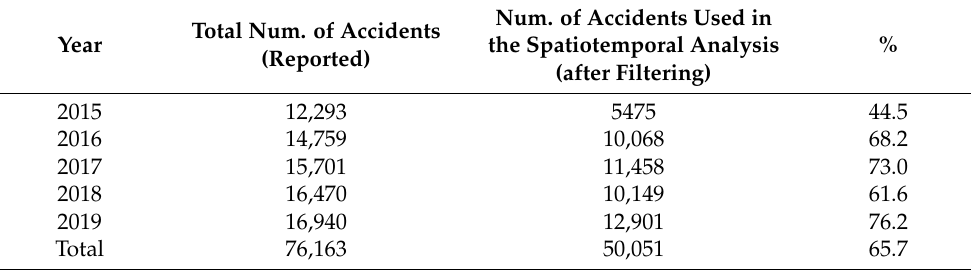
Figure 3. Examples of the confusing clusters of traffic accidents in the study area that represent the reported traffic accidents in a police department instead of its actual location. Table 2. Summary of the number of the reported traffic accidents in the Irbid Governorate during